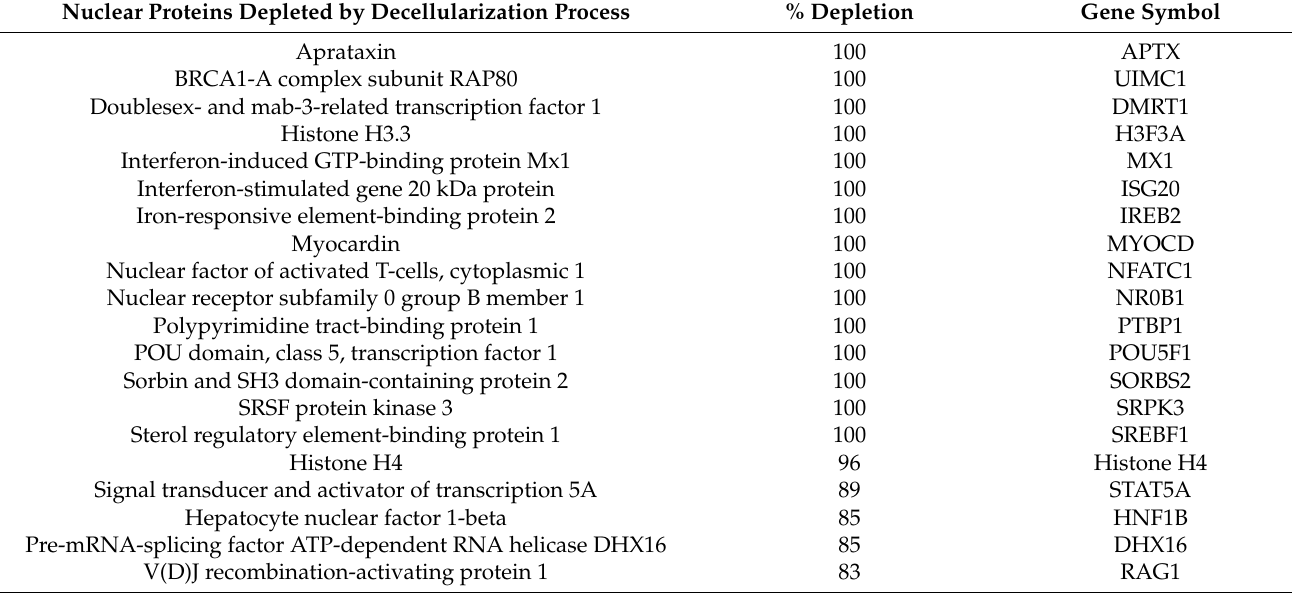
Table 1. Proteomic analysis of proteins removed by decellularization.